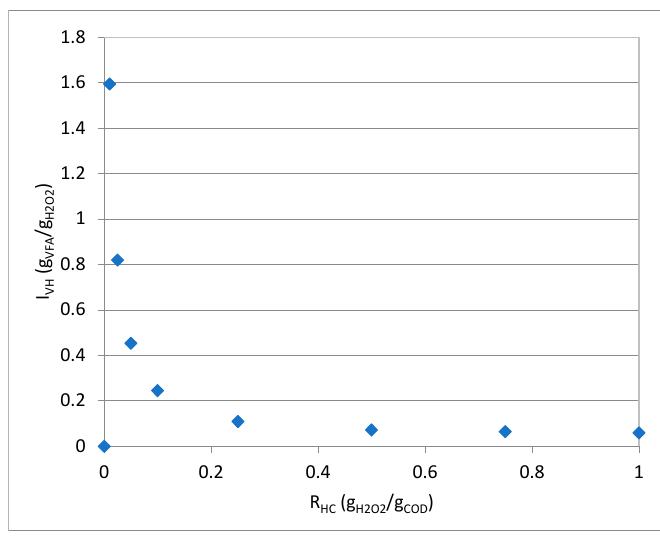
Figure 3. I VH ratio detected in the AHP tests conducted with different H 2 O 2 dosages.